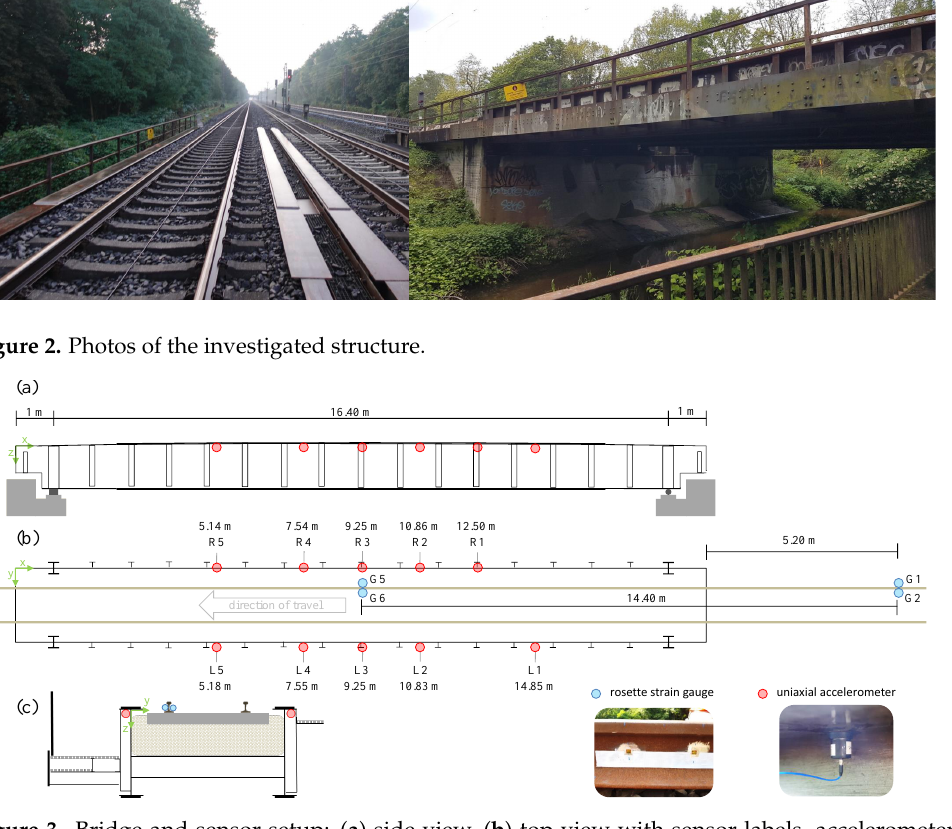
Figure 3. Bridge and sensor setup: ( a ) side view, ( b ) top view with sensor labels, accelerometer x -ordinates, and strain gauge distances, ( c ) cross